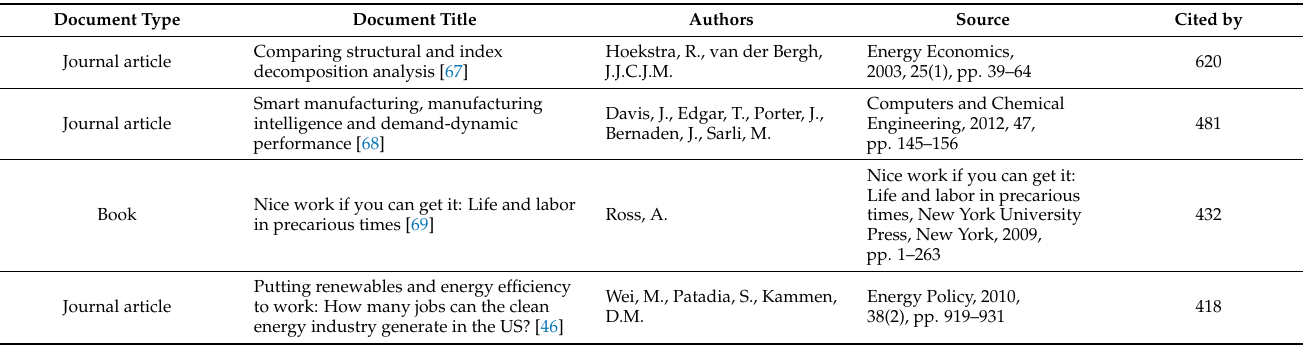
Table 5. Top Four most cited publications dedicated to the subject of